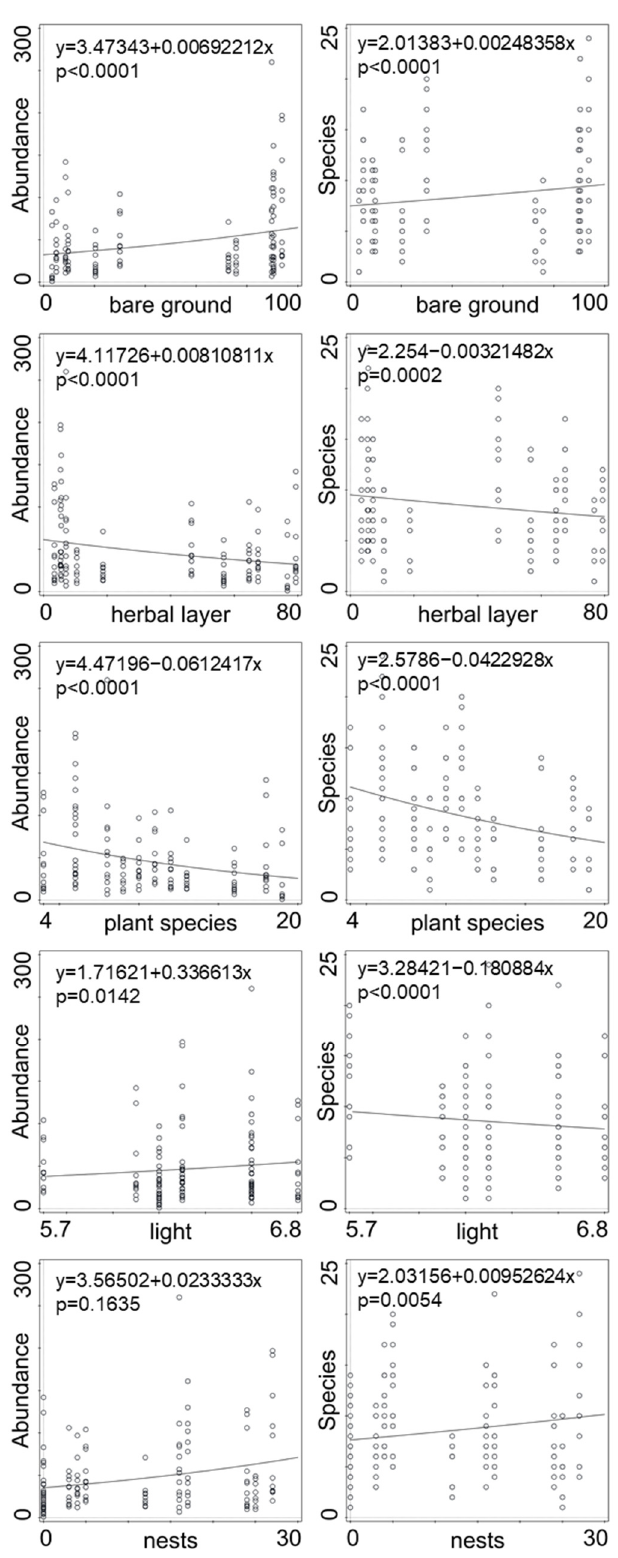
Figure 1. Significant factors and their effect on the abundance and number of species (GLM). Bare ground—percentage of patches without vegetation; herbal layer—coverage (%) of ground by herbs; plant species—number of plant species; light—value of Ellenberg index for light; nests—mean number of cormorant nests per 100 m 2 . R2 for whole minimal adequate model for abundance of predatory arthropods is 0.792 and 0.689 for number of species, respectively.